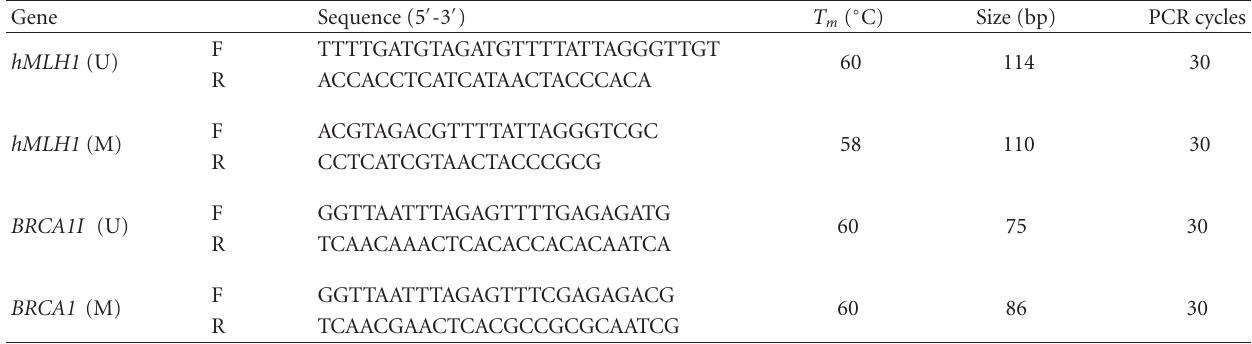
Table 1: Summary of primer sequences, annealing temperature, product size and number of cycle used in MSP assay. M: methylated DNA, U: unmethylated DNA, F: forward, R: